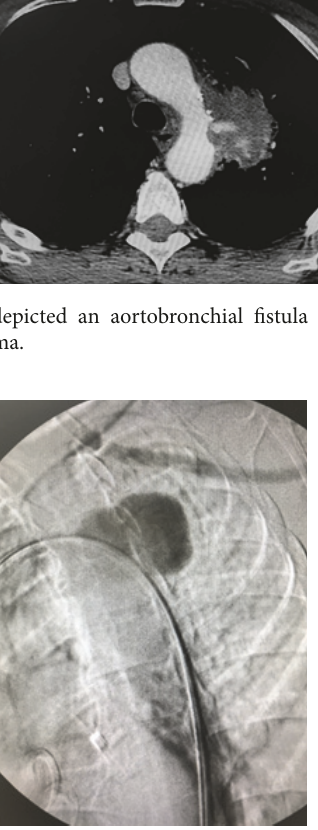
Figure 3: DSA revealed the presence of pseudoaneurysm just distal to the left subclavian artery.